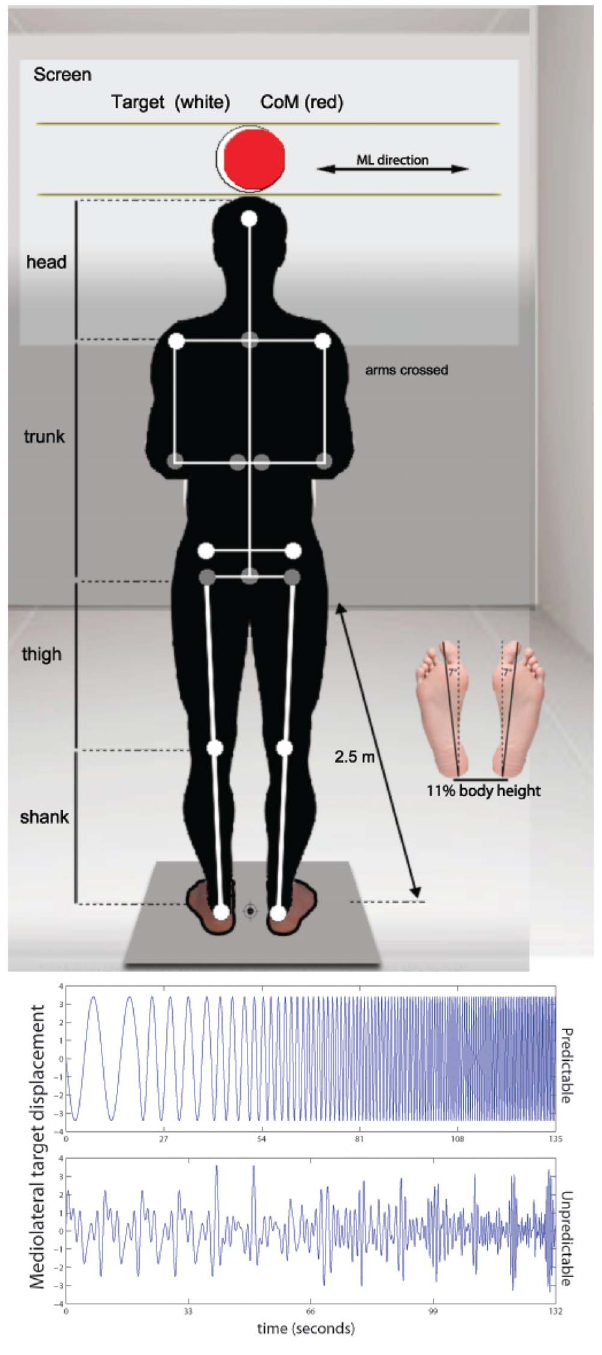
Figure 1. Illustration of the set-up and the model for Center of Mass (CoM) calculation utilized in this experiment, showing a silhouette of a subject standing in the middle of a forceplate with marker placement superimposed (in white actual makers and in grey estimated joint centers) and the display of the CoM feedback (red sphere). The white sphere in the centre represents target which moved in the mediolateral (ML) direction following the patterns depicted in the bottom panel: predictable (top) and unpredictable (bottom). An insertion of foot soles is presented showing foot positioning during the experiments (stance width and